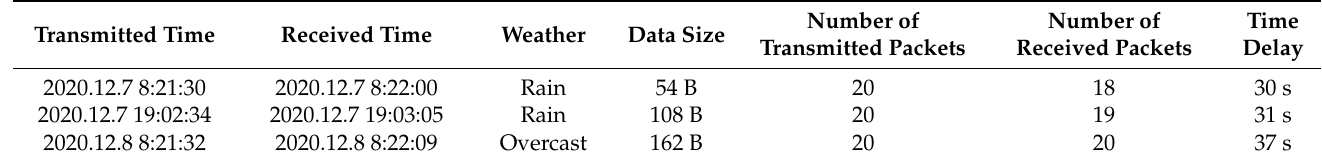
Table 2. System time delays (without the packet creation mode).